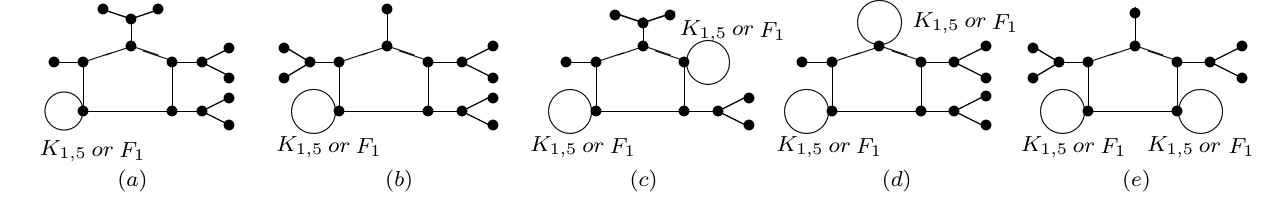
Fig.9. Possible graphs on G with the proof of Lemma 3.13